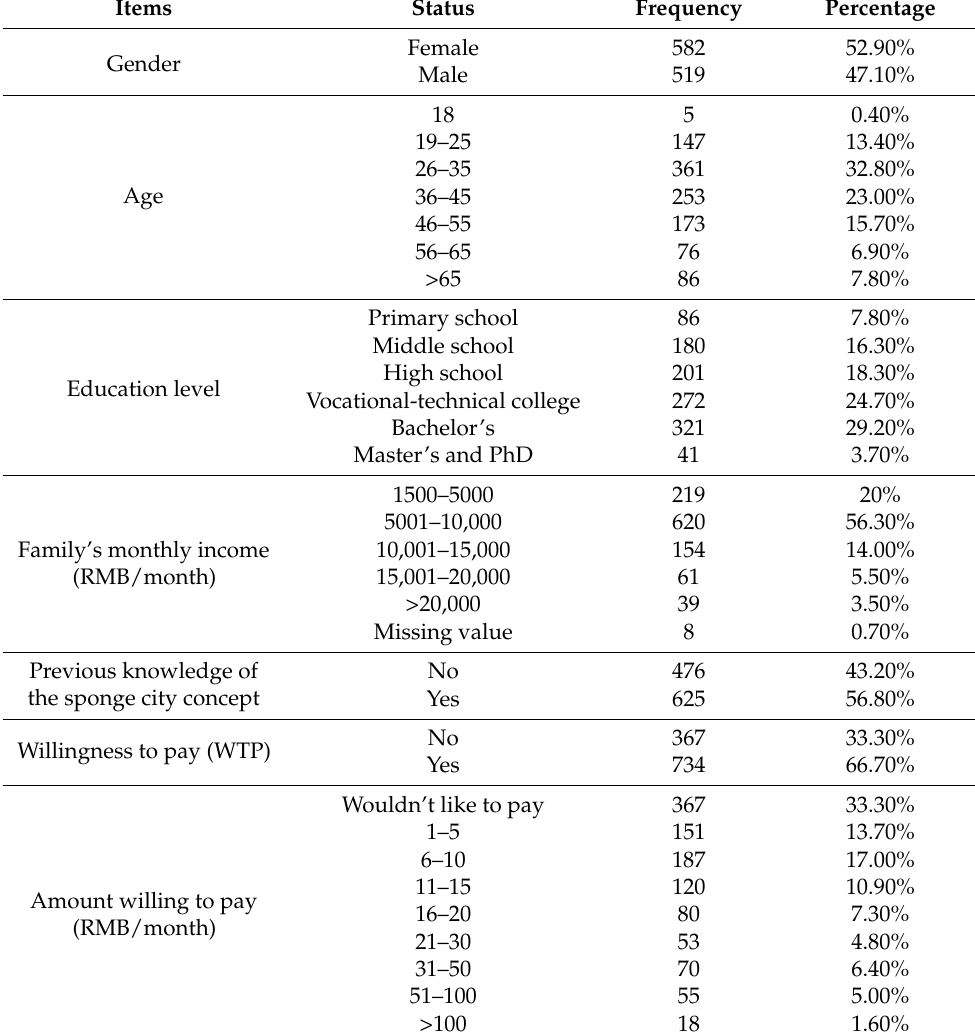
Table 1. Profiles of respondents’ demographic information and